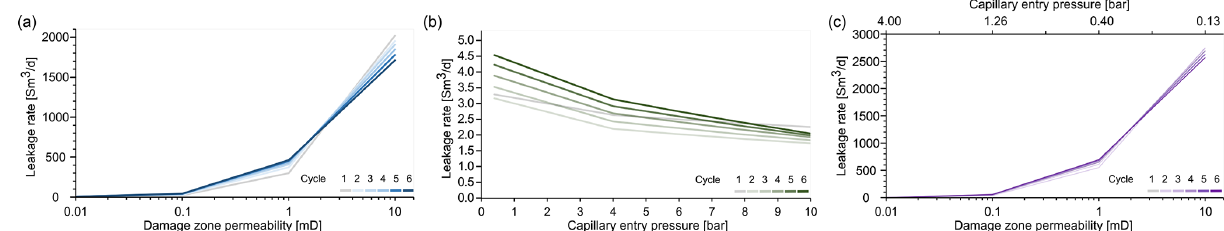
Figure 7. Comparison of the influence of fault zone parameters on the average leakage rate during six injection periods; Parameters: (a) dam- age zone permeability; (b) capillary entry pressure; (c) scaled capillary pressure and damage zone